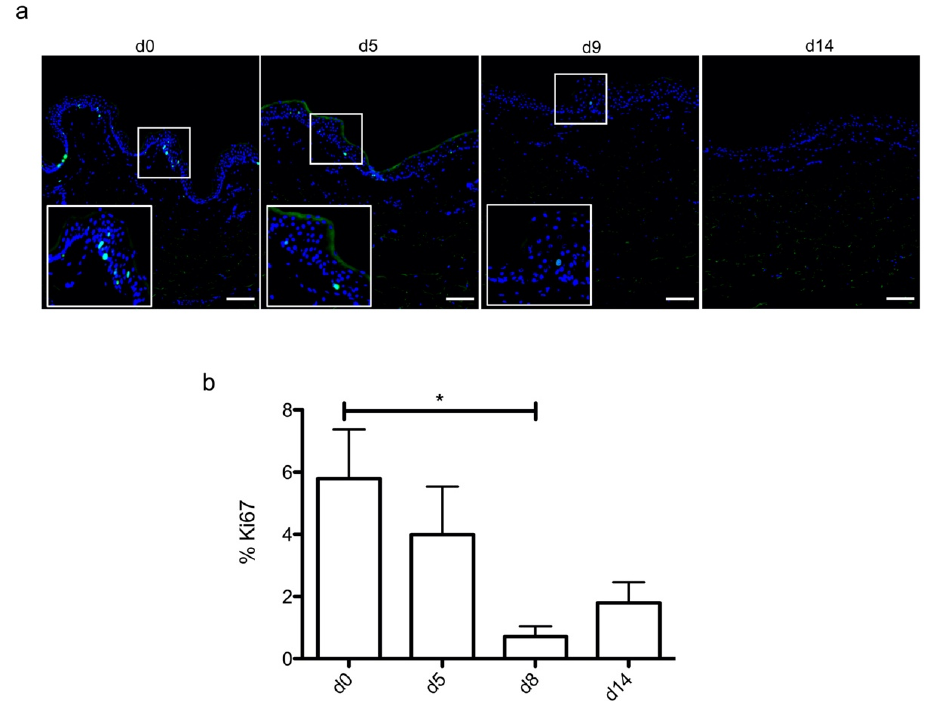
Figure 2. Demonstration of a persisting proliferating potential in the basal keratinocytes of cultured human skin explants. ( a ) Immunostaining of the proliferation marker Ki67 was performed on